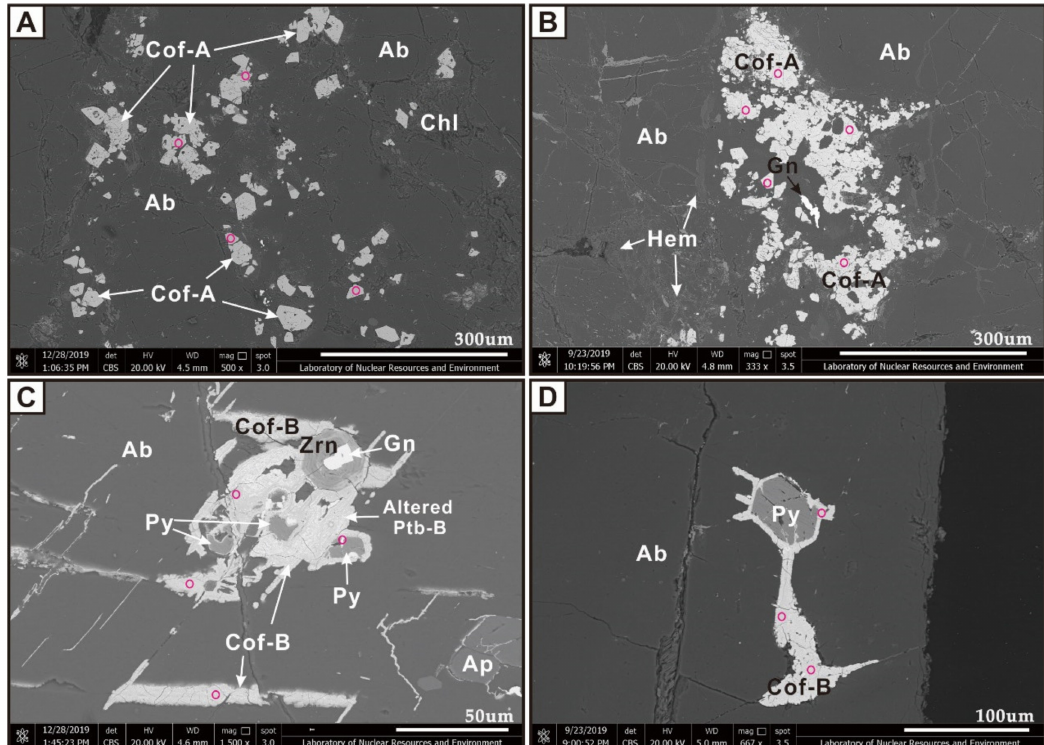
Figure 6. Backscattered electron (BSE) images of co ffi nite A and co ffi nite B in the Jiling uranium deposit. ( A ) Co ffi nite A occurs as independent mineral grains in the albite and coexisting with chlorite. ( B ) Co ffi nite A crystal aggregates filling fractures in albite with galena, hematite dissemination in albite in its vicinity. ( C ) Co ffi nite B and altered pitchblende B around zircon and pyrite crystals and as veinlet infilling, galena in the core of a zircon crystal. ( D ) Co ffi nite B filling microfractures of albite and rimming a pyrite crystal. Ab—albite; Ap—apatite; Brt—barite; Cof—co ffi nite;